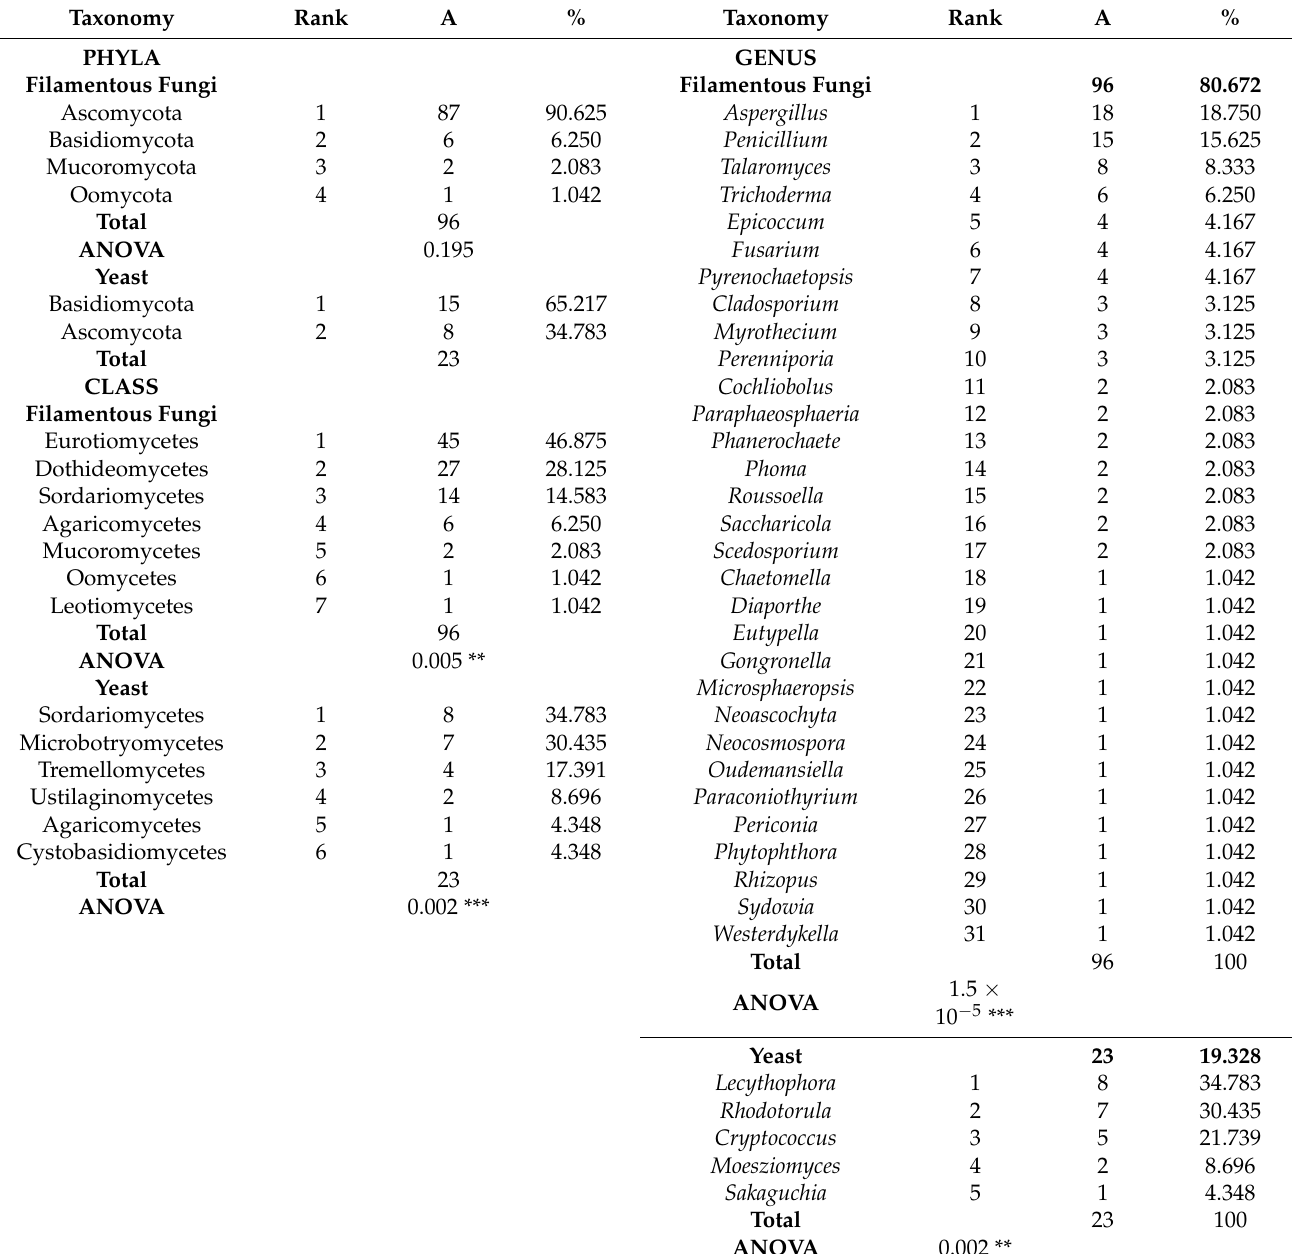
Table 6. Ranked abundance of fungi and